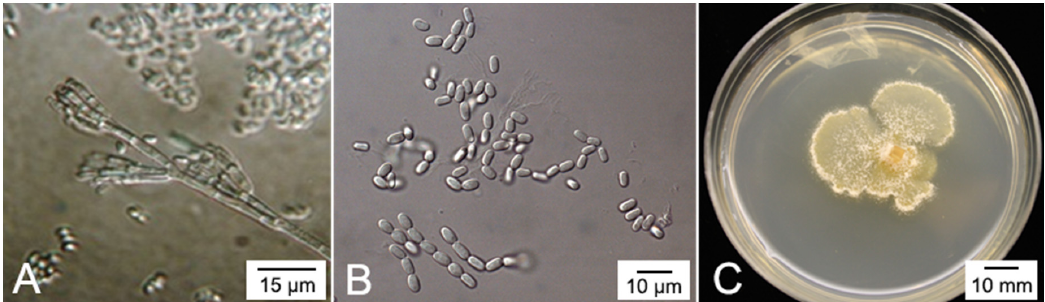
Figure 2. The fungal pathogen of Thousand Cankers Disease, Geosmithia morbida . Light micrograph image of G. morbida conidiophores ( A ) and conidia ( B ); G. morbida isolate grown in 10% potato dextrose agar plate ( C ).